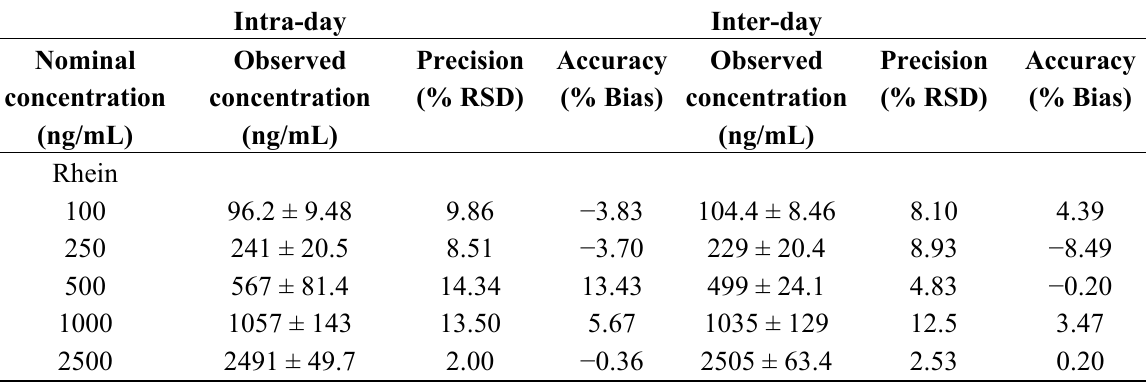
Table 4. Intra- and Inter-day precision (% RSD) and accuracy (% bias) of the UPLC-MS/MS method for determination of rhein in rat plasma (6 days, six replicates per